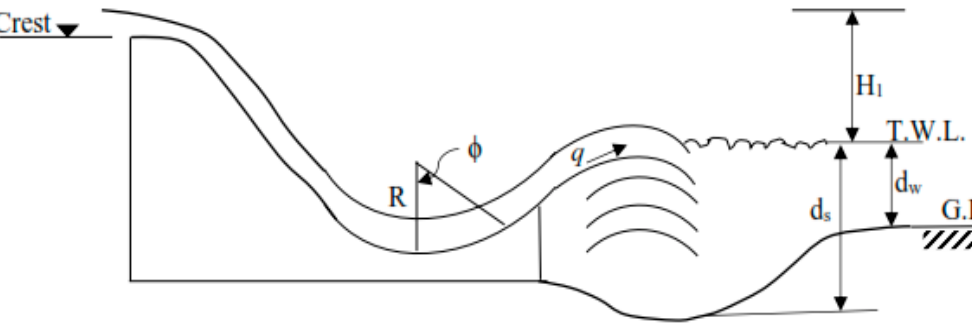
Figure 1. A schematic cross-sectional view of ski-jump spillway scour. Table 2. Statistical parameters of data.